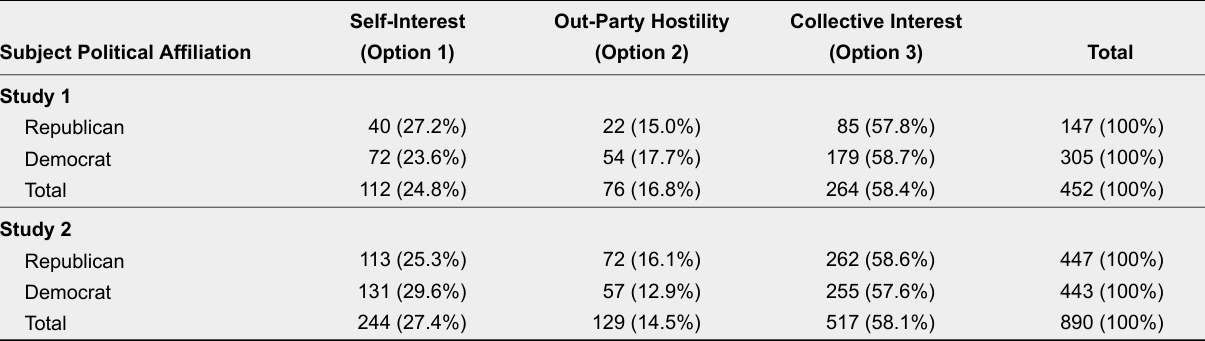
Economic Game Decisions in Studies 1 and